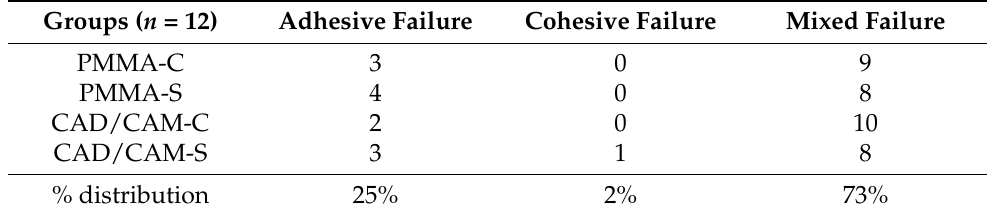
Table 1. Failure mode distribution of the